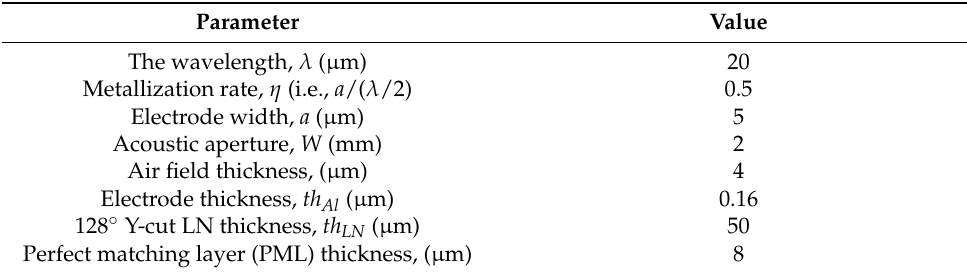
Table 3. Initialization of the simulation model.